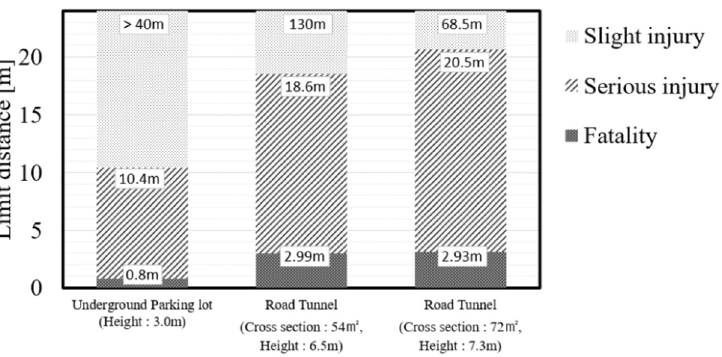
Figure 19. Limit distances according to space conditions for the explosion of a 52 L hydrogen tank.